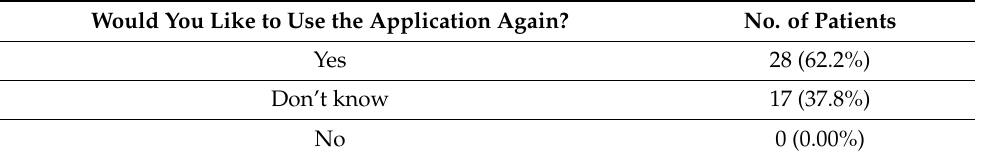
Table 4. The game evaluation questionnaire